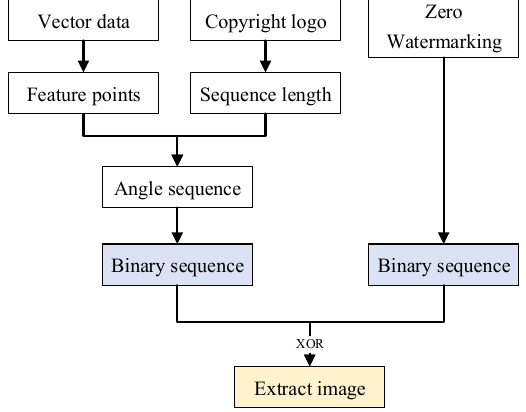
Figure 5. Zero watermarking construction process.